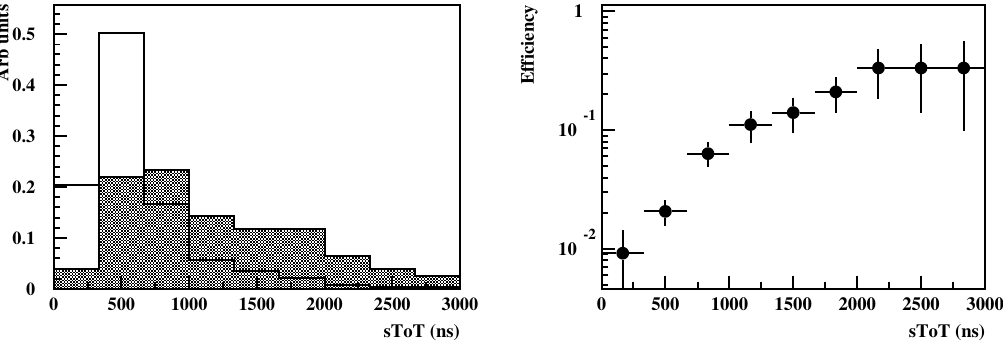
Figure 4. ( Left ) the distribution of the sToT value for shower data with identified RF signals (filled histogram) and for shower data without RF signals (unfilled histogram). ( Right ) the measured efficiency of detecting RF signals as a function of the sToT value in double station coincidence